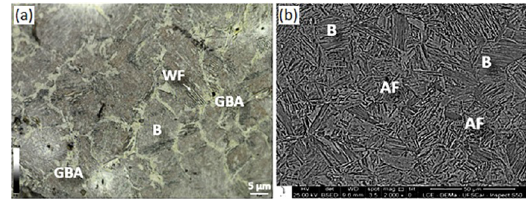
Figure 4. 0.01 Nb steel: the first shows the microstructure after quenched at 900 ºC (Nital 2% - COM). The second shows the microstructure after quenched at 900 ºC and tempered at 600 ºC (Nital 2% - MEV).